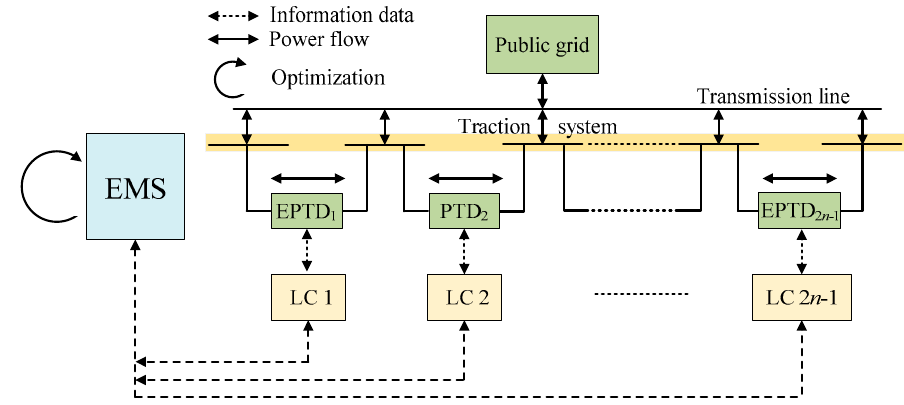
Figure 3. Structure of centralized control for the modified system. EMS: energy management system.